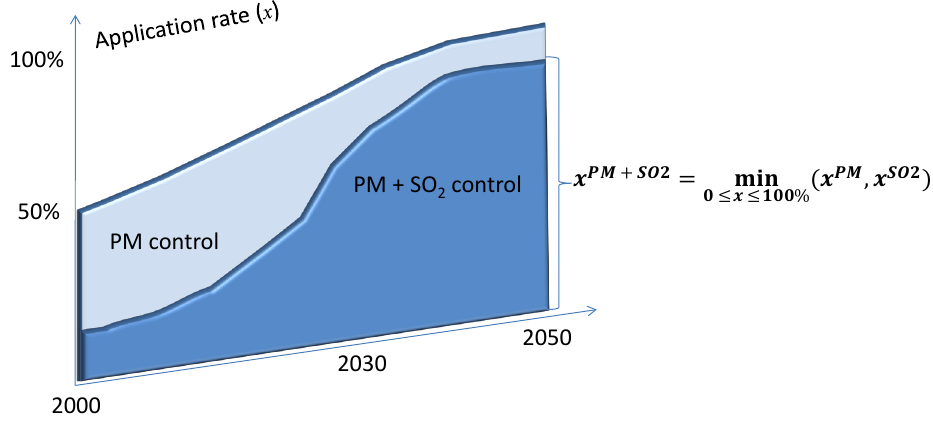
Figure 2. Illustration of a multi-pollutant technology approach for Hg control in